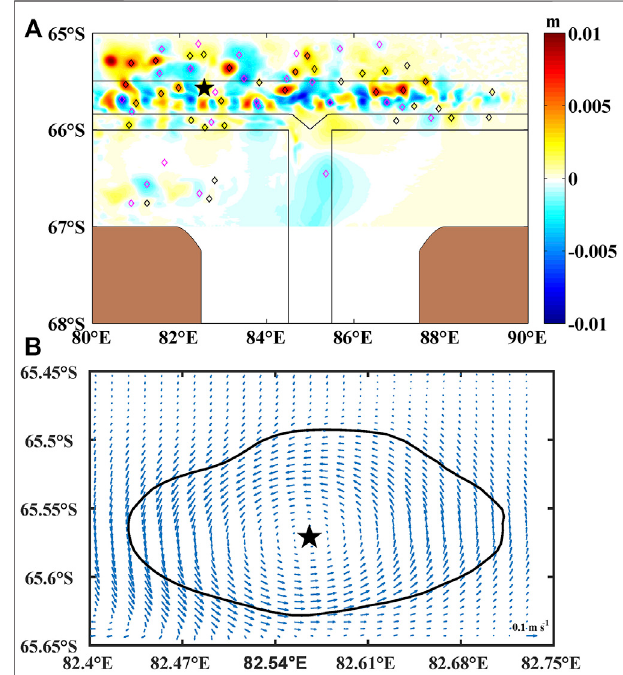
FIGURE 4 | (A) A snapshot of eddy centers detected by the vector geometrymethod.TheblackdiamondsarethedetectedCE,andthemagenta diamonds are the detected AE. The color shading is sea surface height anomalies. The thin black lines denote the isobaths of 500, 700, and 3,000 m from south to north. The black star denotes an anticyclonic eddy shown in (B) . (B) The snapshot of an anticyclonic eddy with sea surface velocity vectors in units of m s − 1 . The black line denotes the boundary of the detected anticyclonic